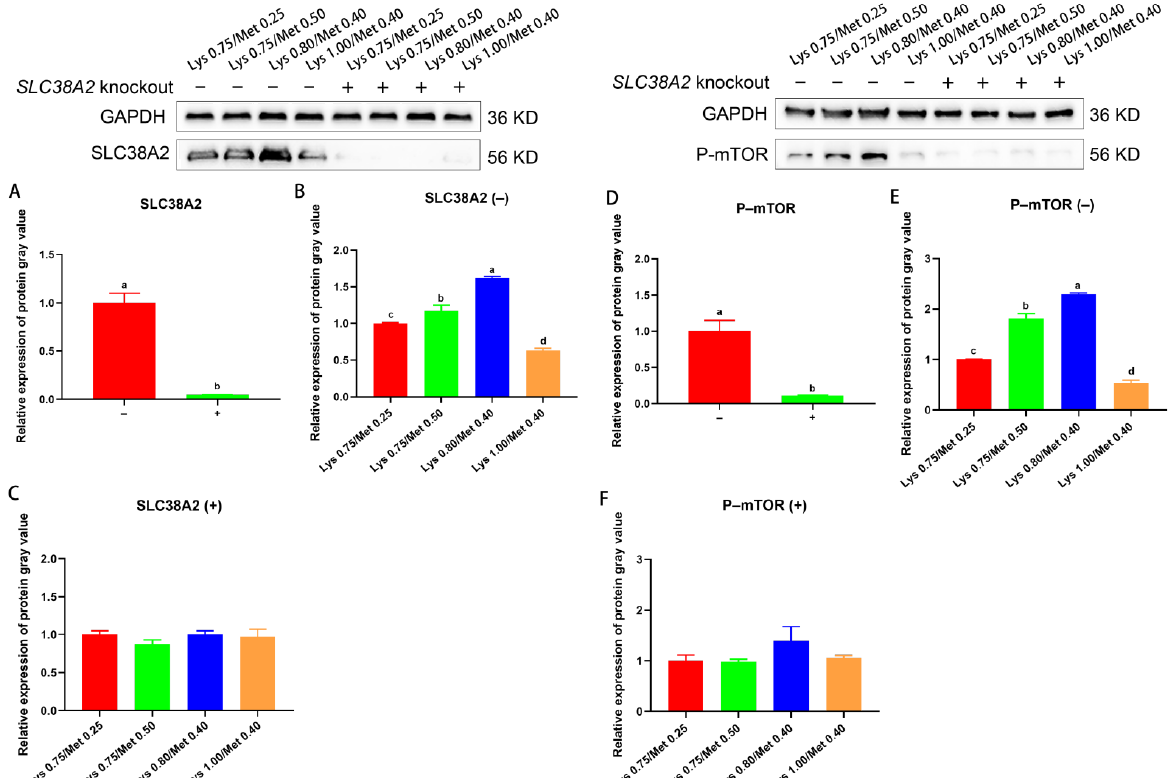
Figure 5. Effects of different lysine and methionine composition on SLC38A2 – mTOR signaling